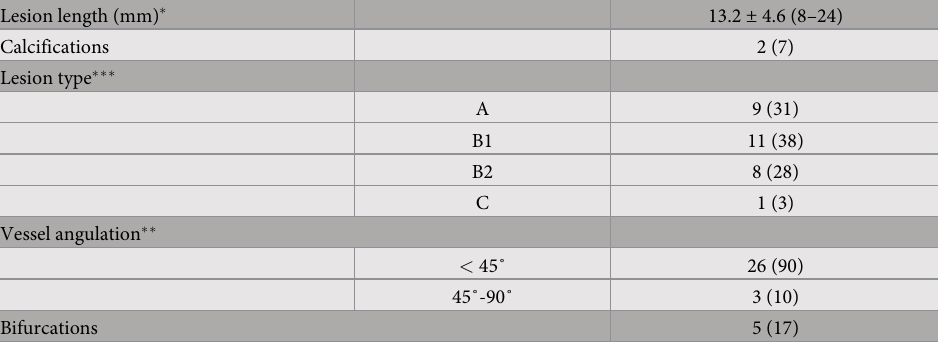
Table 4. Pre-implantation lesion characteristics as assessed on conventional angiography (N stents = 29).